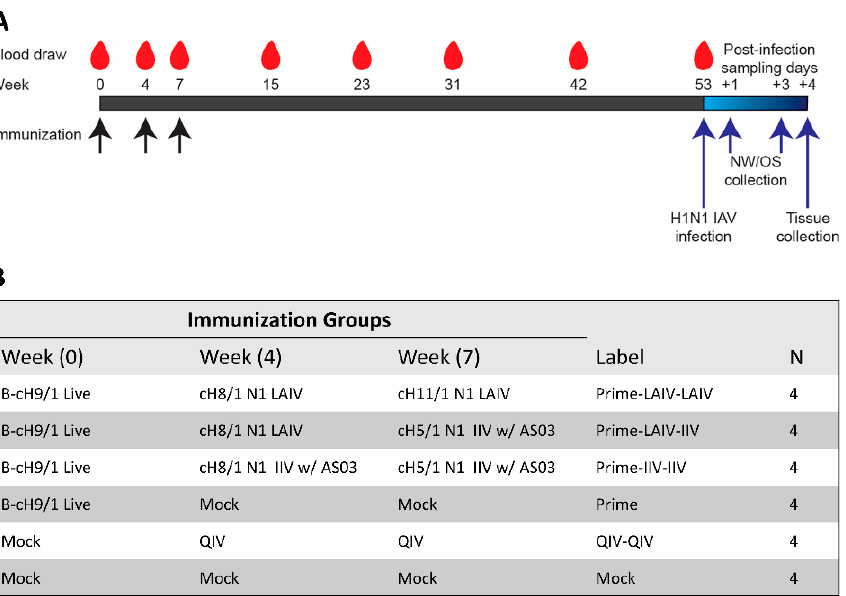
Figure 1. Overview of the longitudinal vaccination study and experimental groups. ( A ) Sequential immunization strategy to induce long-lived H1 stalk immunity. Immunizations (black arrows) and blood collection days (red drops) are indicated. All ferrets were challenge infected with pH1N1 (Cal/09) influenza A virus 379 days post-prime immunization. Nasal wash (NW) and Oropharyngeal swab (OS) specimens were collected on days 1 and 3 post-challenge infection. Blood and tissue specimens were collected on day 4 post-challenge infection. ( B ) Experimental and control groups. All ferrets that received the cHA-based vaccines were primed with the influenza B virus expressing cH9/1 (B-cH9/1) live virus. The primed ferrets next received a booster immunization of cH8/1 N1